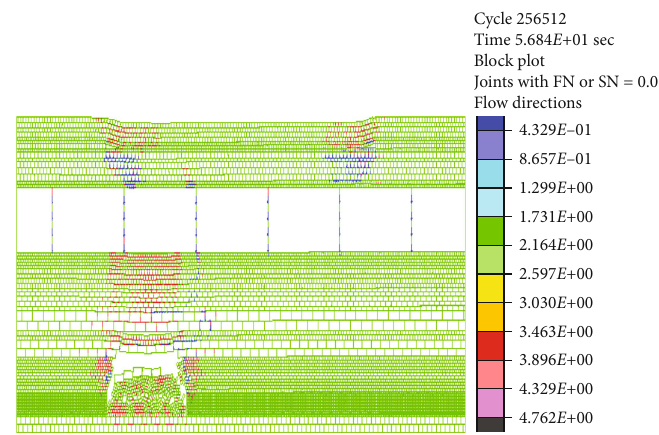
Figure 8: The fl ow velocity vector distribution in initial caving of key layer 1.